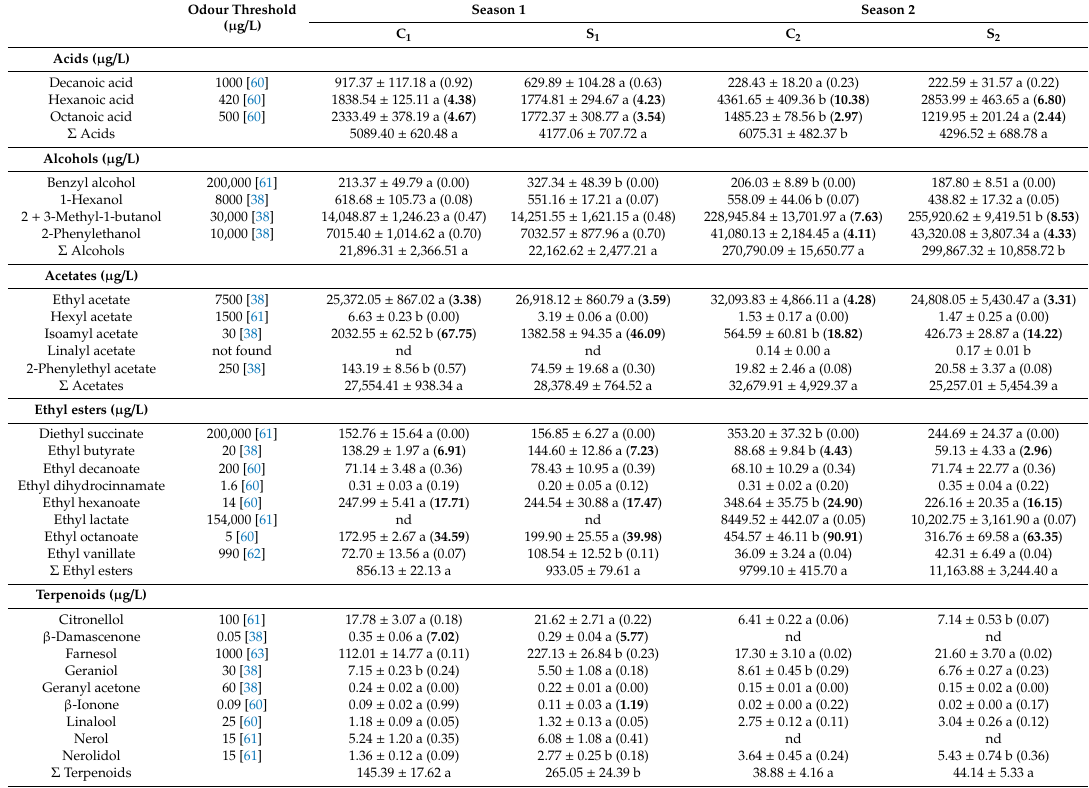
Table 3. Volatile compounds determined in Bobal